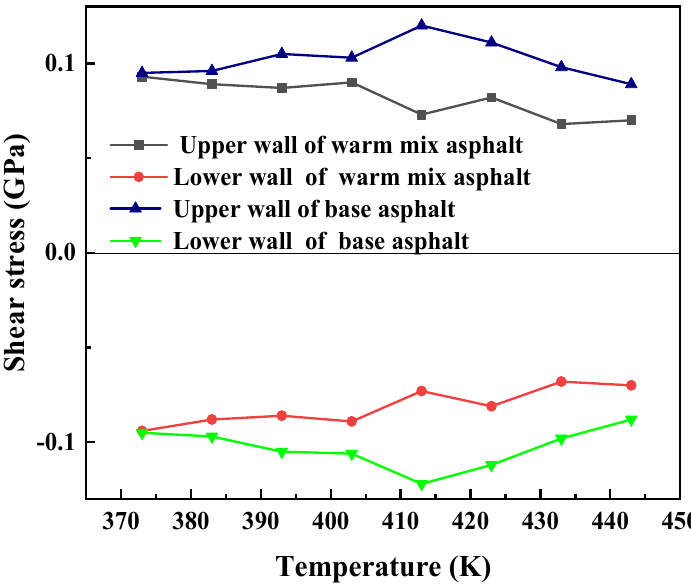
Figure 9. Effects of temperature on the stress of the film.